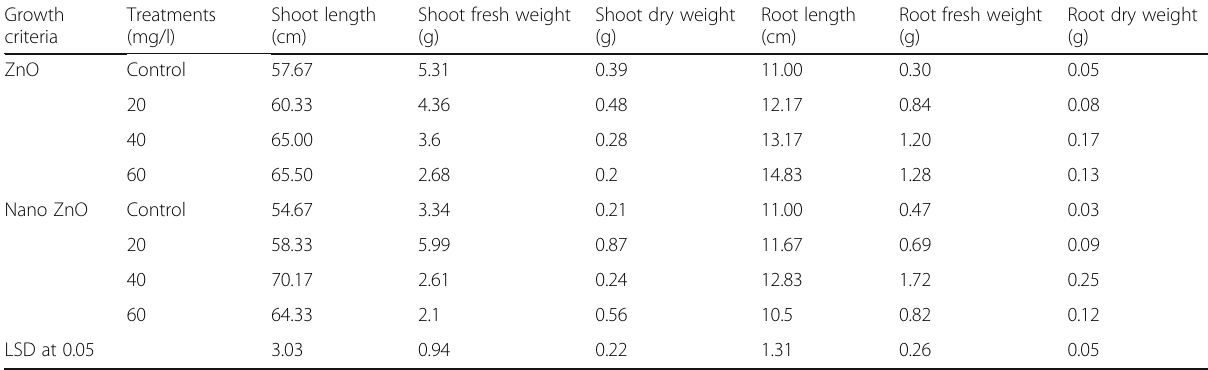
Table 3 Effect of ZnO or nano ZnO (0, 20, 40, and 60 mg/l) on growth criteria of flax plant under sandy soil (data are means of two